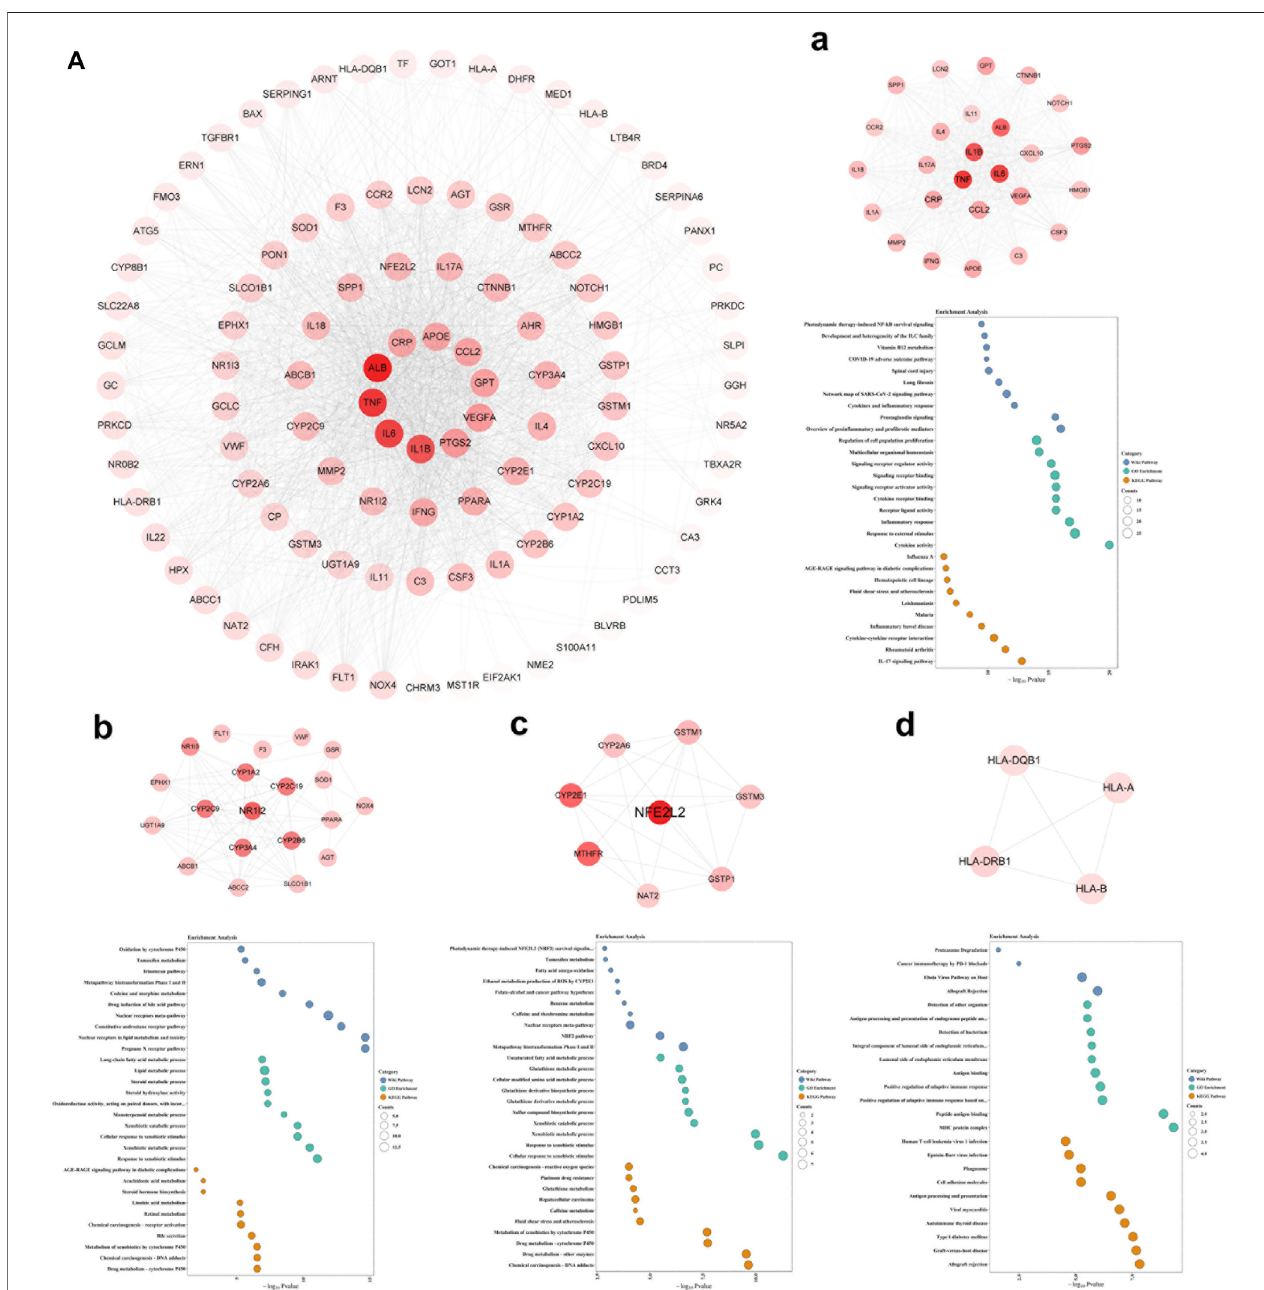
FIGURE 4 | DPTS-induced liver injury regulatory network (A) and MCODE clusters with their top 10 GO, KEGG, and WP pathways functional enrichment results. Cluster 1 (a) , cluster 2 (b) , cluster 3 (c) , and cluster 4 (d) . GO, gene ontology; BP, biological processes; MF, molecular function; CC, cell component; KEGG, kyoto encyclopedia of genes and genomes; WP, wikipathway.